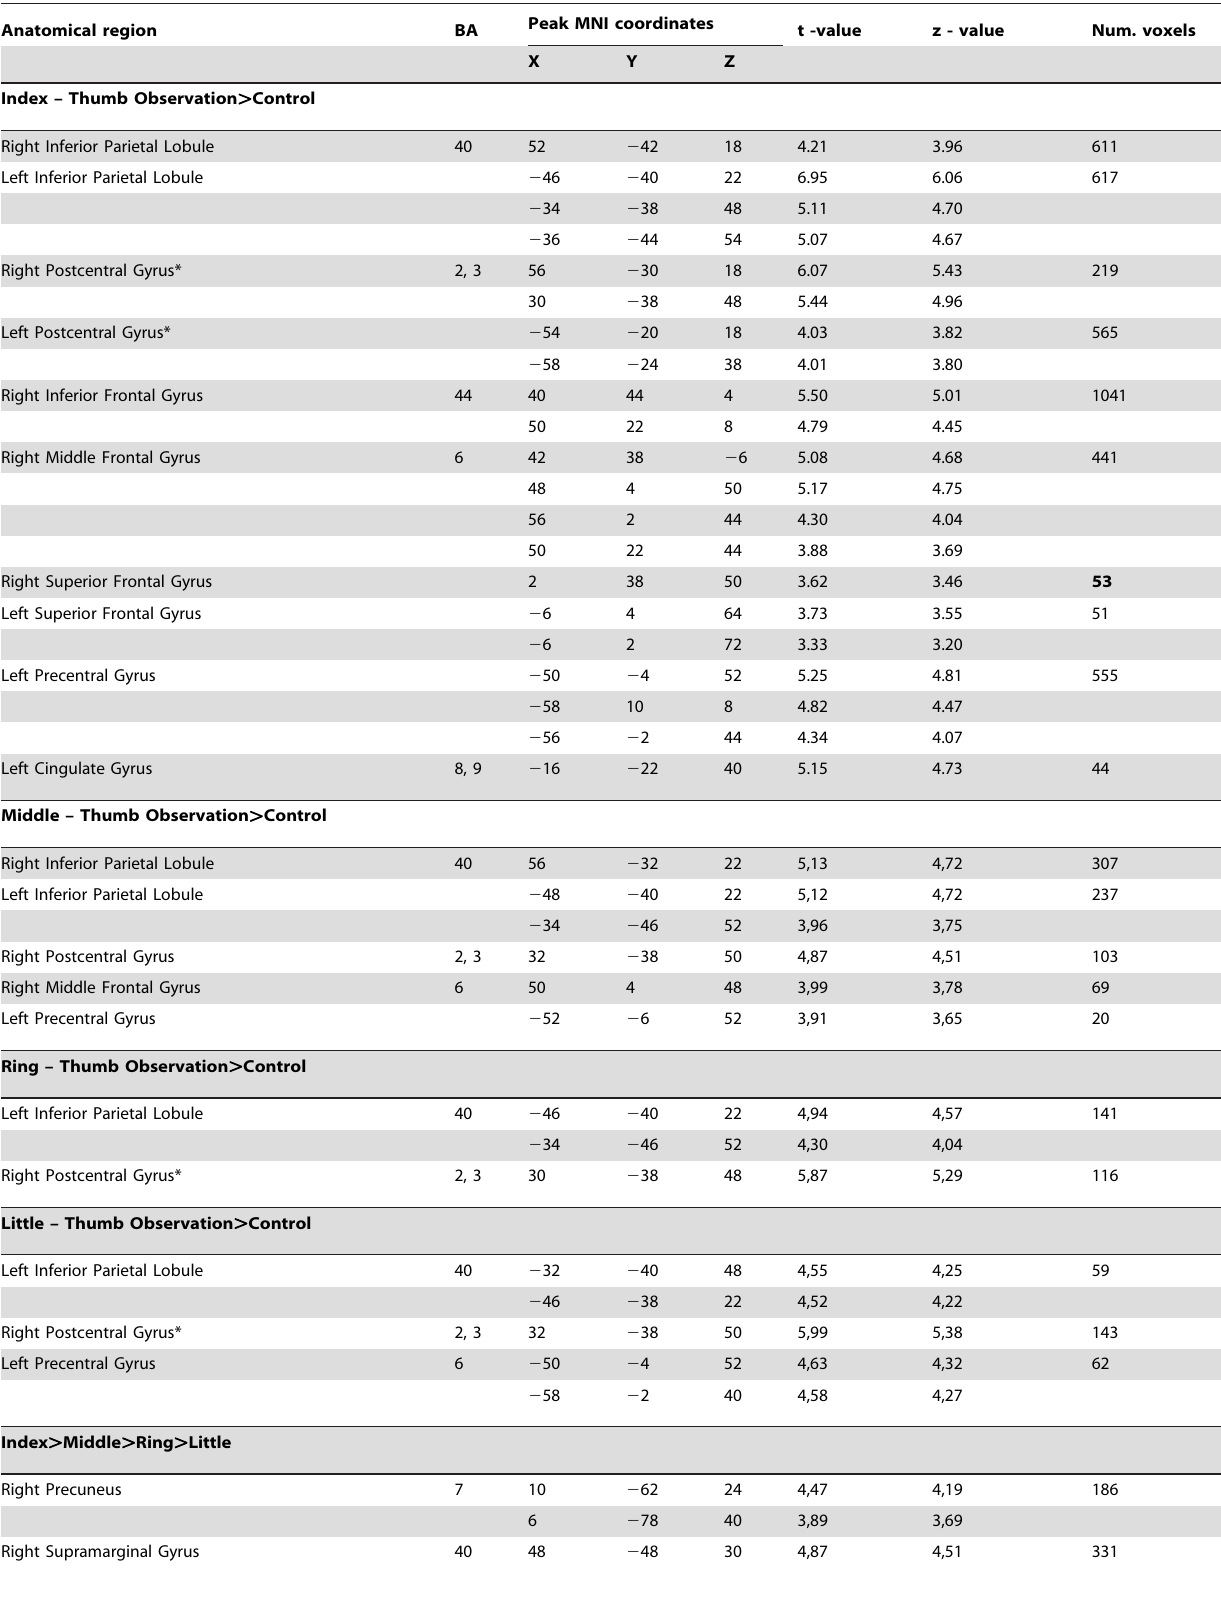
Table 1. Activation peaks with their locations.